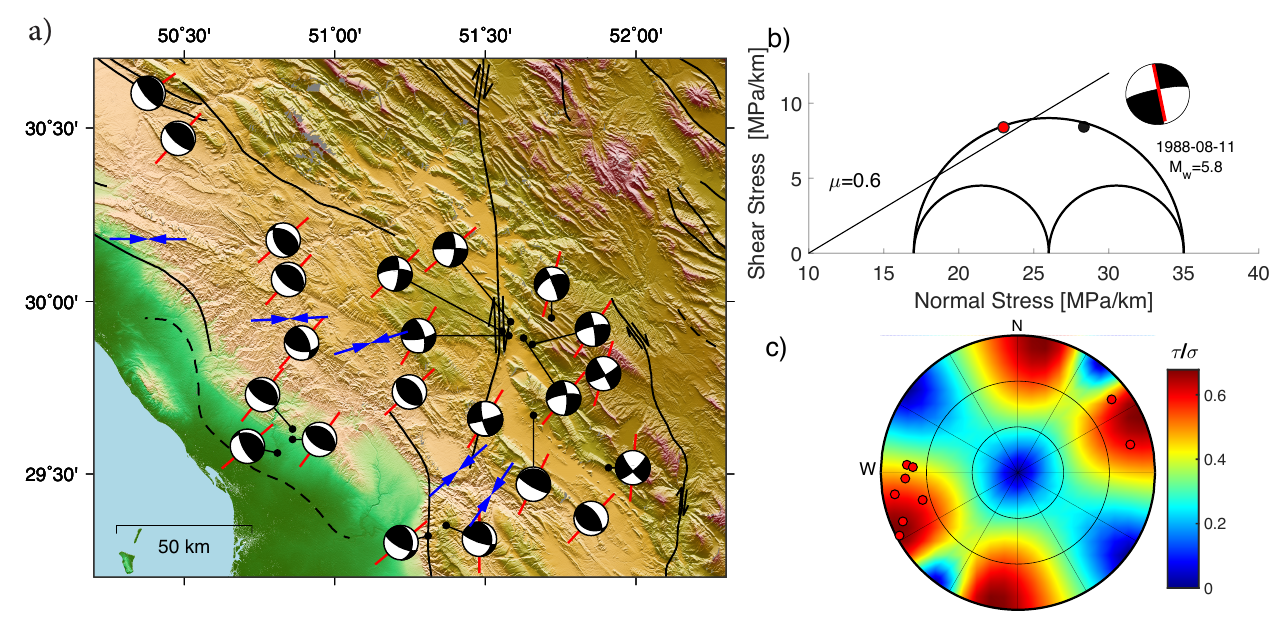
Figure 8. ( a ) Earthquake focal mechanisms in the vicinity of the N-S Kazerun transverse active fault. The state of stress changes from strike-slip faulting around the fault to a reverse faulting regime on either side, whereas the seismologically ( red line ) determined azimuth S Hmax (P-Axis) is stable and uniform around the area. ( b ) 3D Mohr’s circle showing a representative strike-slip focal mechanism and resolved shear and normal stresses for each nodal plane. The red line on the focal beach-ball indicates the actual fault plane. ( c ) Lower hemisphere stereonet plot illustrates the slip-tendency (ratio of resolved shear to normal stress) for strike-slip faulting regime nearby Kazerun Fault System and actual nodal plane for 12 fault plane solutions mapped in ( a